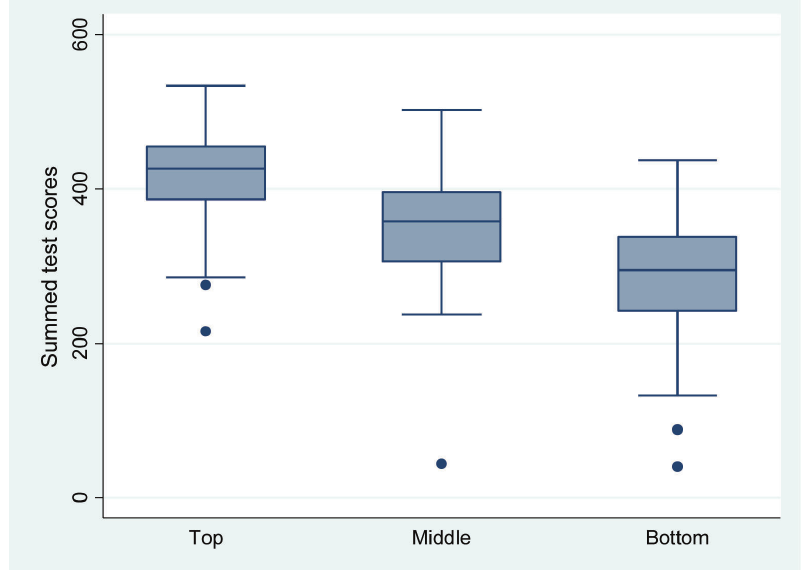
Figure 4: Distribution of summed test scores: sample pupils across streams n = 829; Mean for all pupils = 366.6. Line represents median, box represents 25th and 75th percentiles (Q1 and Q3, respectively), whiskers represent Q3+1.5(Q3–Q1) /